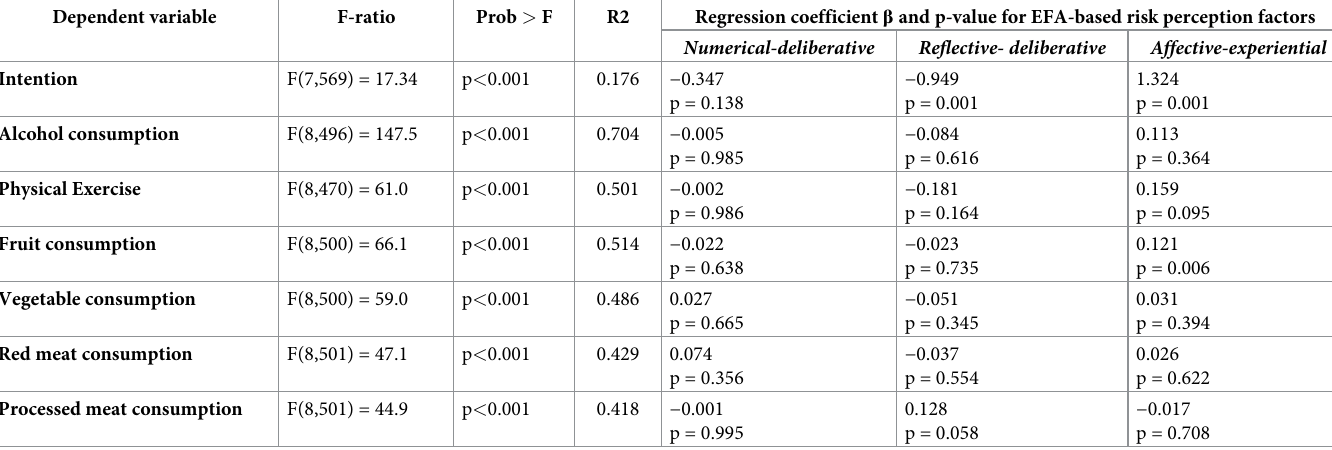
Table 8. Multivariable regression analysis of factors of risk perception vs. intention and